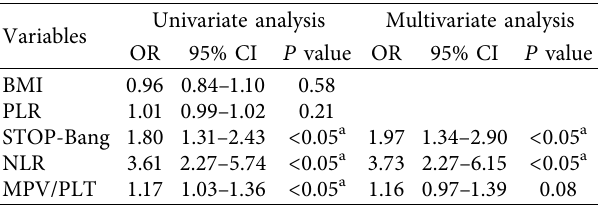
Table 4: Univariate and multivariate logistic regression analysis results: significant variables for predicting OSA in TBAD patients (groups A and